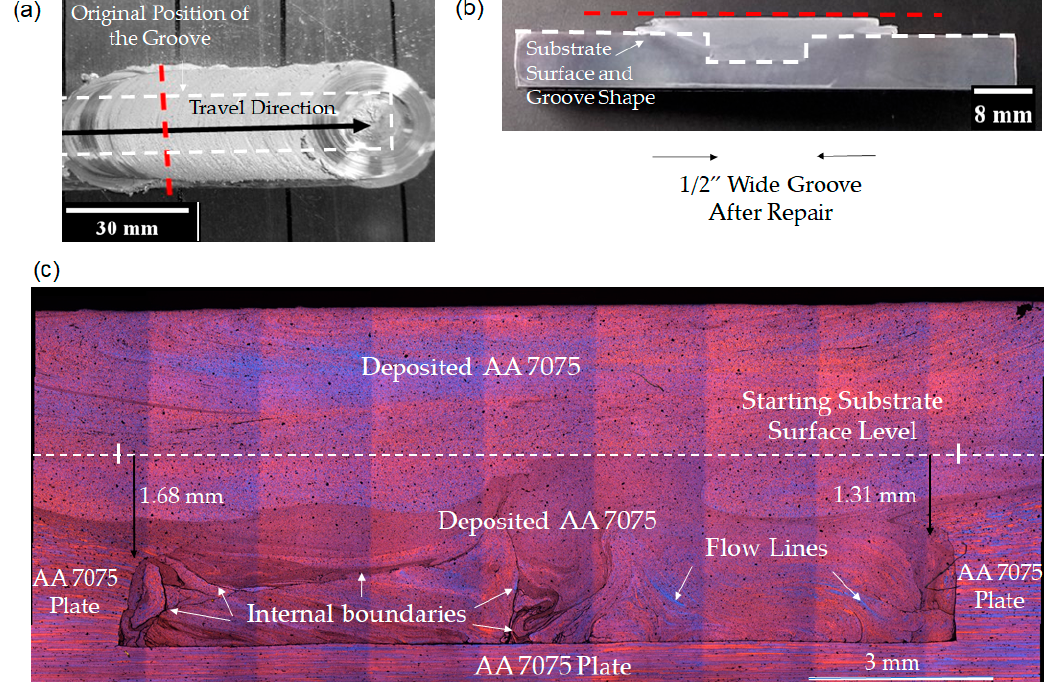
Figure 7. ( a ) Top-down view of completed deposition for the groove fill sample with the tool traverse marked; ( b ) cross-sectional view of the groove fill sample taken at the red dotted-line; ( c ) full cross-section of the groove filling sample, created by stitching together several optical micrographs.